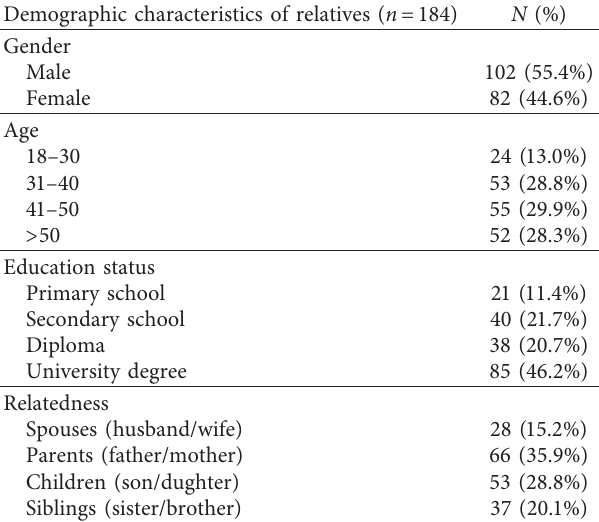
Table 1: Characteristics of ICU patient’s